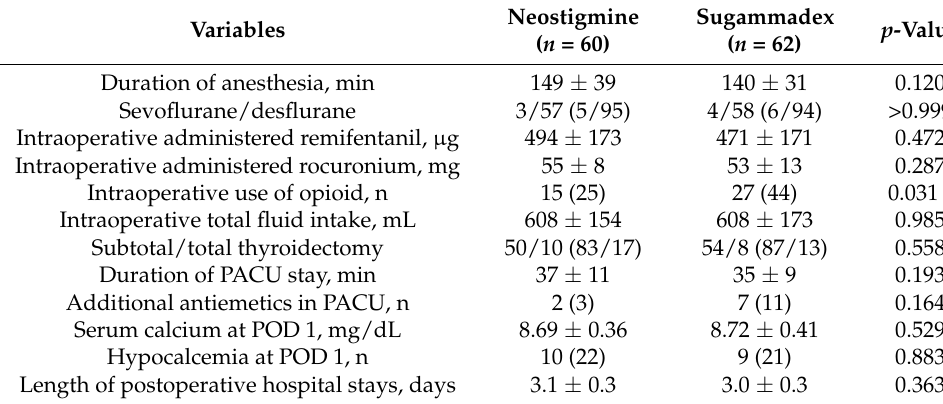
Table 2. Perioperative variables.